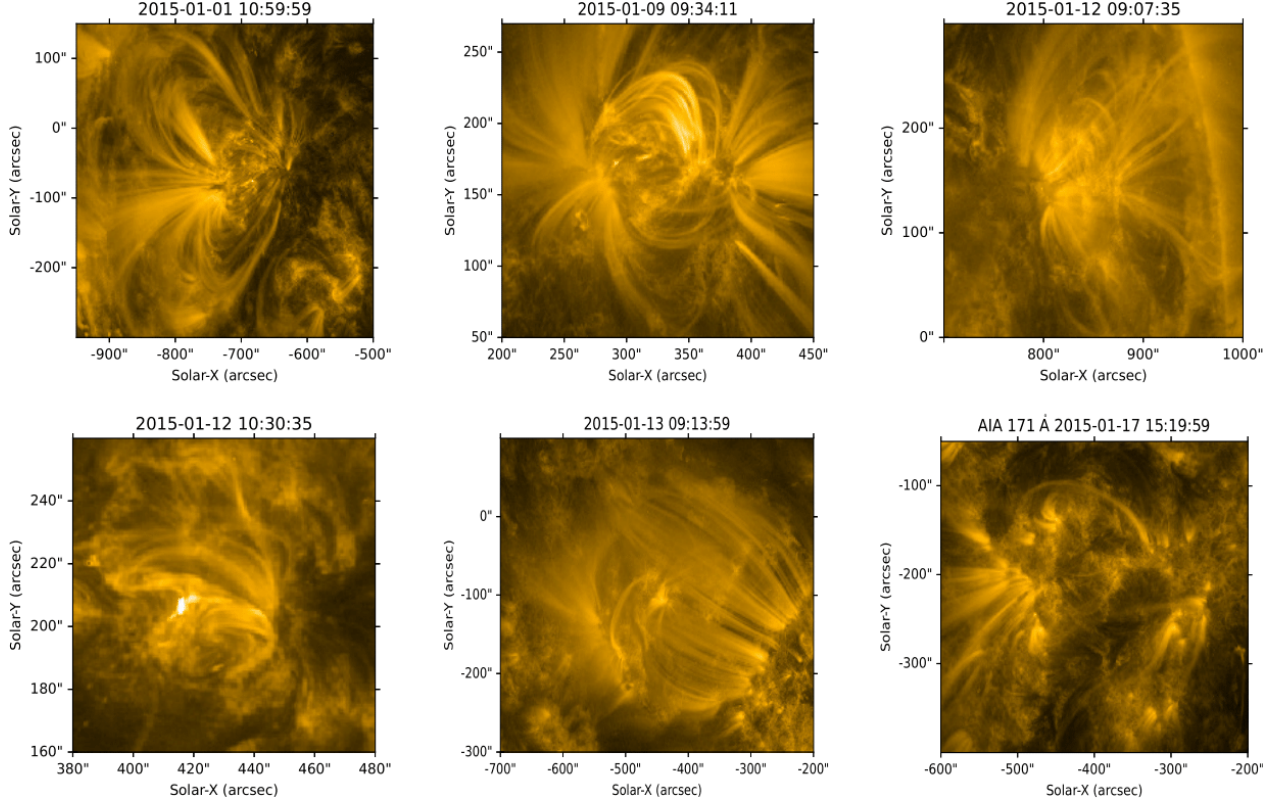
Figure 7. The magnetic loops embedded in the solar corona indicating the potential site of trapped electrons responsible for type IV emis- sions. The figure displays a sample of six AIA/SDO images in the 171Å band filter corresponding to the dates of type IV radio bursts in January